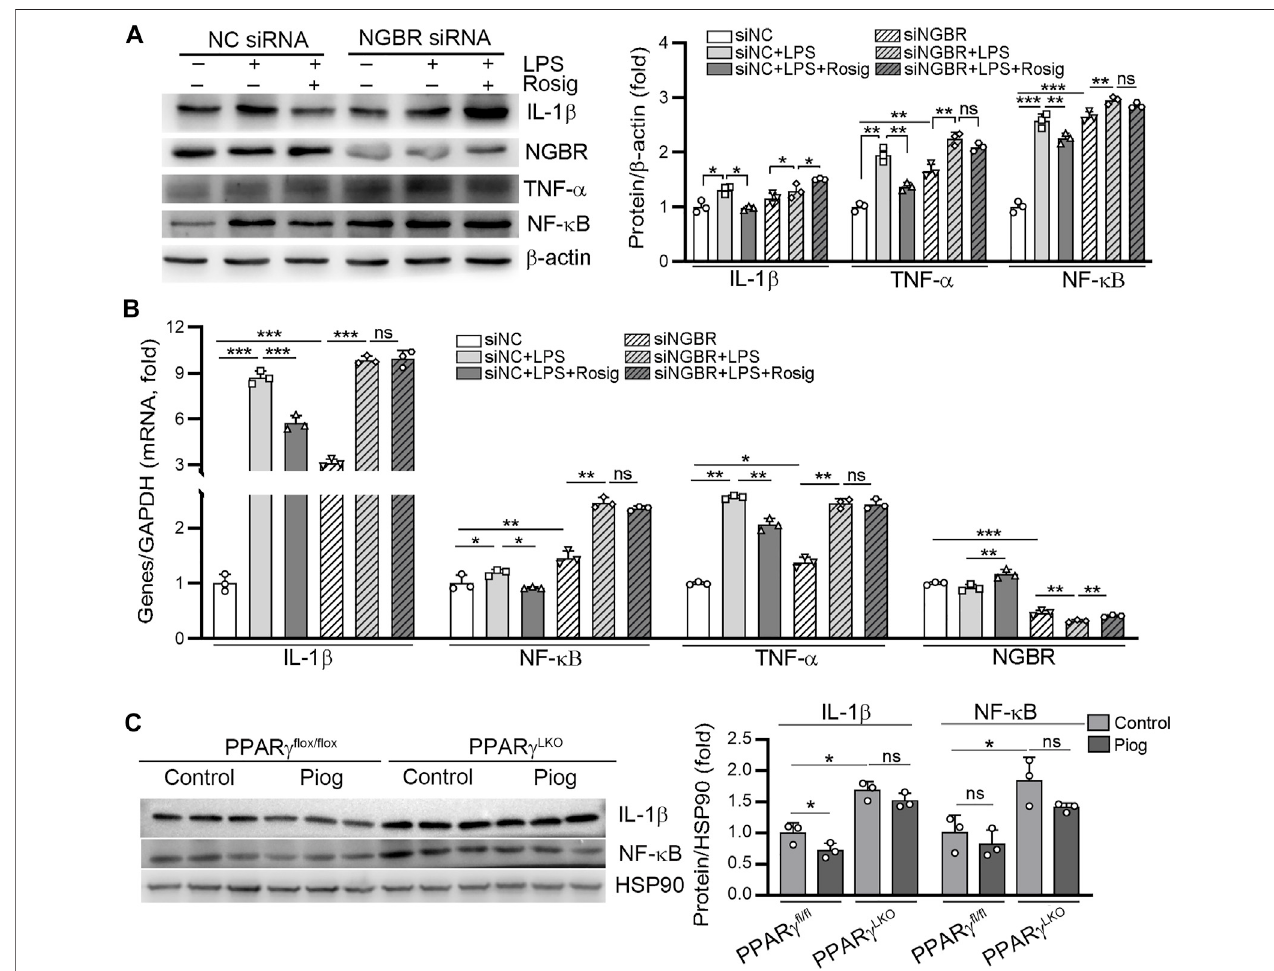
FIGURE5| PPAR γ attenuatesLPS-inducedin fl ammationbyregulatingNGBR. (A,B) HUVECinasix-wellplateweretransfectedwithcontrolsiRNA(NCsiRNA)orNGBRsiRNA for 24 h in serum-free medium, followed by switching the cells into complete medium to culture for another 24 h. After treatment with rosiglitazone (10 μ M) for 12 h, all the cells were addedwithLPS(100 ng/ml)inthepresenceorabsencerosiglitazoneforanother12 h.ExpressionofIL-1 β ,TNF- α ,NF- κ BandNGBRproteinandmRNAwasdeterminedbyWestern blot (A) or qPCR (B) , respectively.Valueswereexpressed asmeans ± SD.* p < 0.05;** p < 0.01;ns,notsigni fi cant( n (cid:1) 3). (C) livertotalproteinswerecollected from Figure 4 . Expression of IL-1 β and NF- κ B in mouse liver was determined by Western blot. Values were expressed as means ± SD. * p < 0.05; ns, not signi fi cant ( n (cid:1) 3).